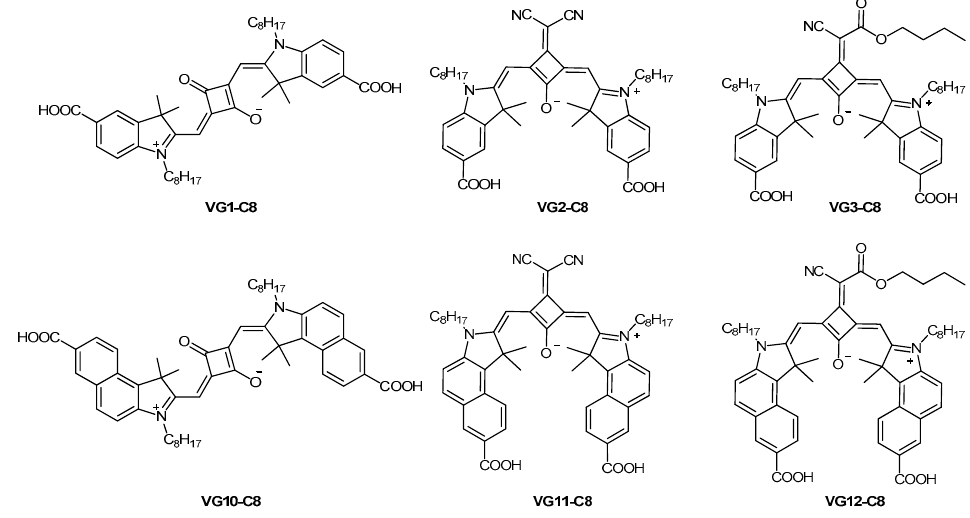
Figure 1. Structures of the four synthesized squaraines (VG2-C8, VG3-C8, VG11-C8, VG12-C8) and of VG1-C8 and VG10-C8 as a comparison.